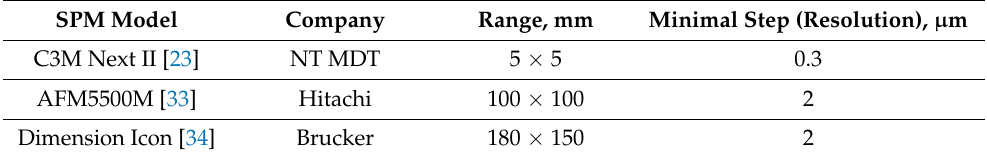
Table 1. Characteristics of probe microscopes. SPM